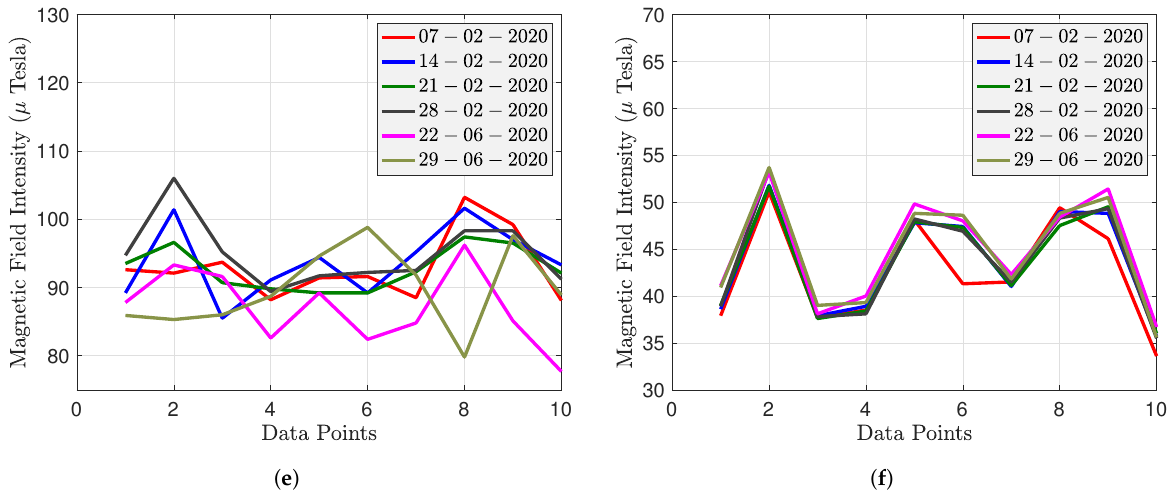
Figure 11. Magnitude of heterogeneous smartphones from 7 February 2020 to 29 June 2020: ( a , c , e ) are the original MF magnitudes of iPhone Xs Max, Huawei P9, and Bluebird, respectively. ( b , d , f ) are the calibrated MF magnitudes of iPhone Xs Max, Huawei P9, and Bluebird, respectively. As shown in Figure 11c, Huawei’s MF measurements from P1 to P7 on 14 February 2020 are abnormal (blue line), but the rest of the time, the MF measurements follow the same trend as the iPhone Xs Max.